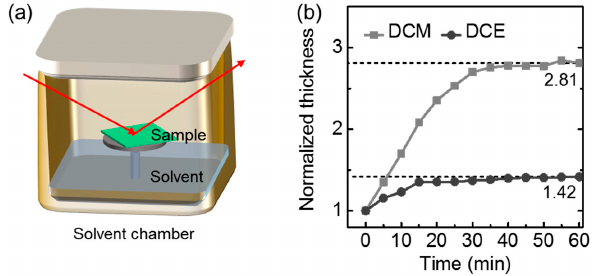
Figure 2. ( a ) Schematic view of the spectral ellipsometry experimental setup; and ( b ) the observed PCPDTBT saturation curve. Two different solvents (dichloromethane (DCM) and 1,2-dichloroethane (DCE)) were used. The initial film thickness was 80 nm.